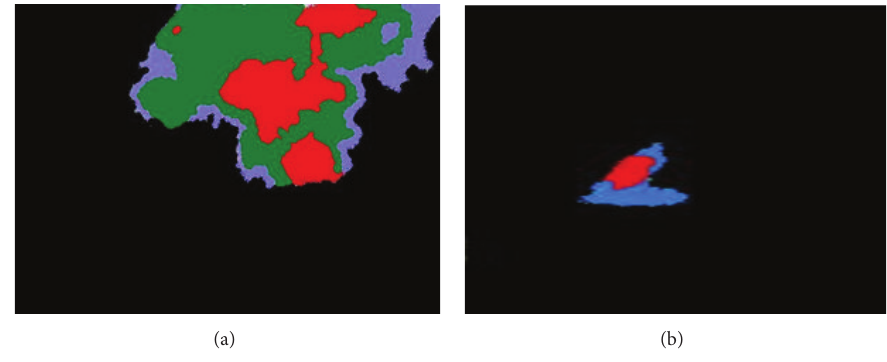
Figure 4: The results after merging small smoke region.